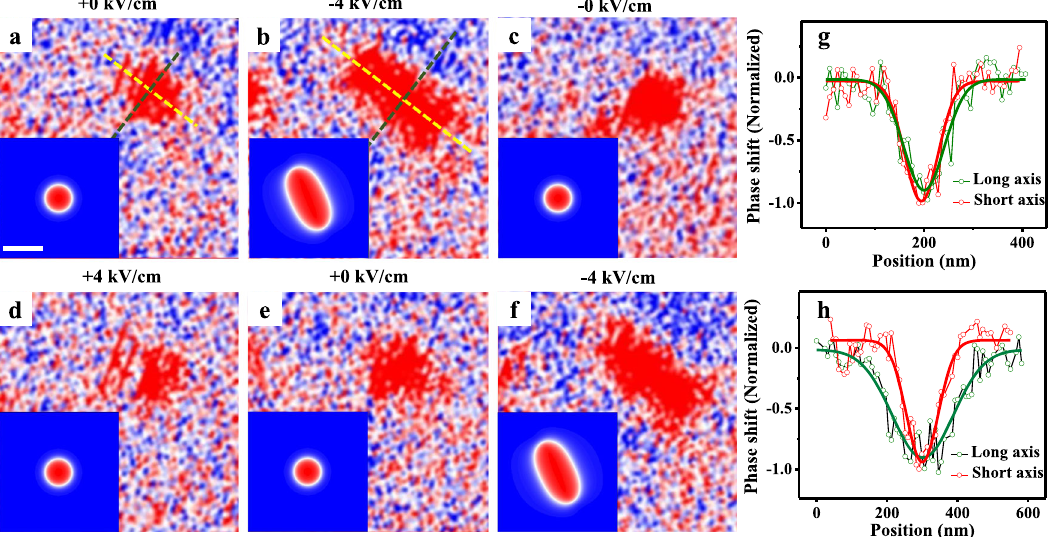
Fig. 4 Skyrmion deformation. Isolated skyrmion morphology at E = + 0 kV/cm ( a ), − 4 kV/cm ( b ), − 0 kV/cm ( c ), + 4 kV/cm ( d ), + 0 kV/cm ( e ), and − 4 kV/cm ( f ) with B bias = 55 mT. g , h Skyrmion line-cut pro fi les along the major and minor axes in a and b with Gaussian fi ttings (solid lines), respectively. The insets in a – f show the simulation results of strain-mediated deformation of one single skyrmion with ε (cid:3) 110 ½ (cid:2) ¼ ε 110 ½ (cid:2) ¼ 0 D = 0.772mJ/m 2 for + 0